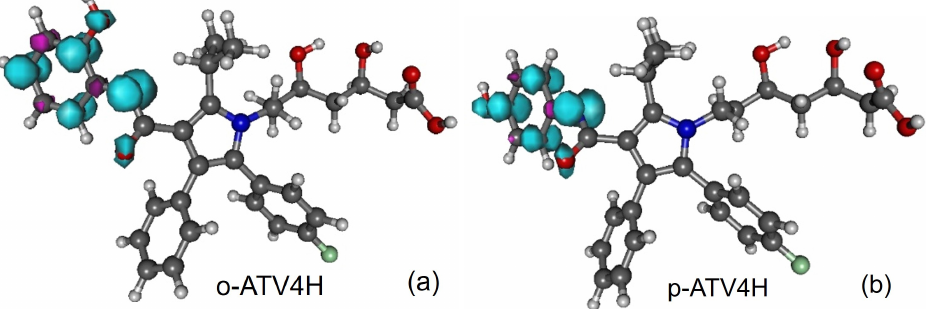
Figure 4. Spin densities of radicals generated from atorvastatin ortho- and para-hydroxy metabolites by H-atom abstraction at position 4-NH: ( a ) o-ATV4H and ( b ) p-ATV4H. Figure generated using GABEDIT